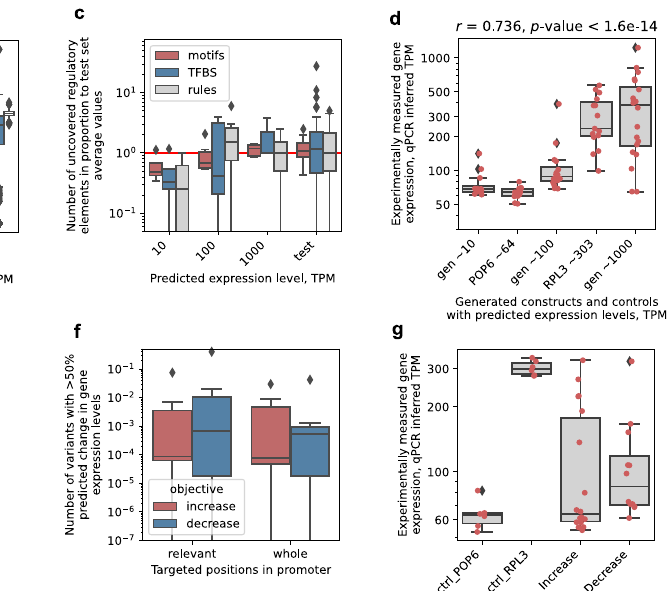
Fig. 6 | Gene expression control using generated regulatory DNA is validated in vivo. a Sequence homology of the experimentally validated variants produced by generator optimization (red) (see Supplementary Table 2) and natural test sequences (blue)to the respective closest representative sequences inthe training dataset across the 4 regions of the gene regulatory structure ( n =81